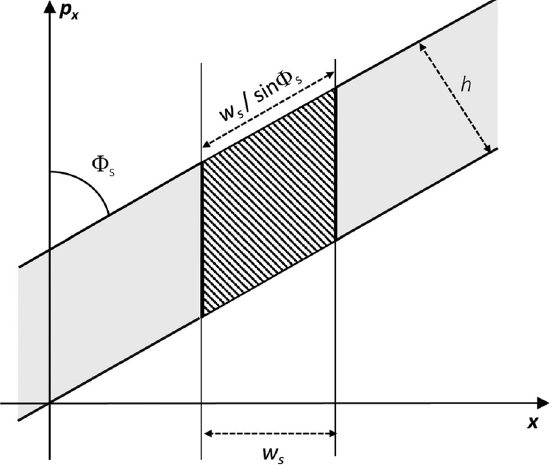
FIG. 19. Idealized separatrix in normalized phase space at ES, where the number of particles impacting the front of the septum is determined by the ES width, separatrix thickness, and the presentation angle of the